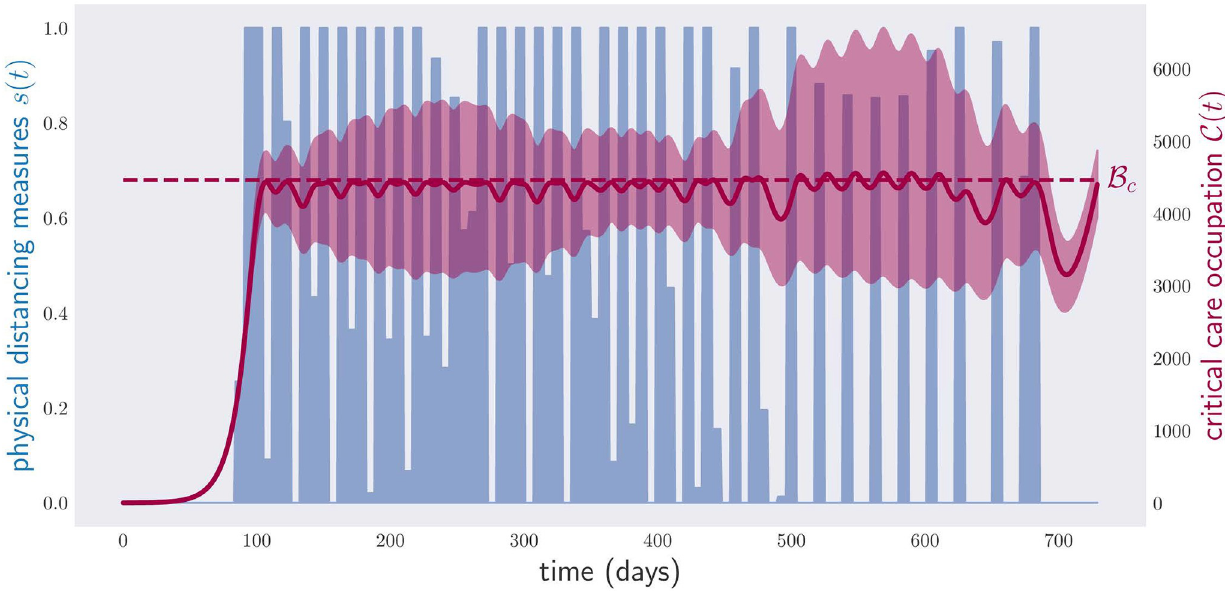
Fig 9. Occupation of critical care beds (red) and (unoptimized) physical distancing measures (blue) for a period of two years under random . The region in red is obtained by sampling 1000 times from the region of model parameters N parameters in N 0 : 05 models with the physical distancing policy optimized over the model with average-value parameters (as in Fig 4). More precisely, the red region is the one delimited by the minimum and the maximum critical care occupation for all the 1000 models, at each time. The red line represents the average critical care occupation in all those simulations.